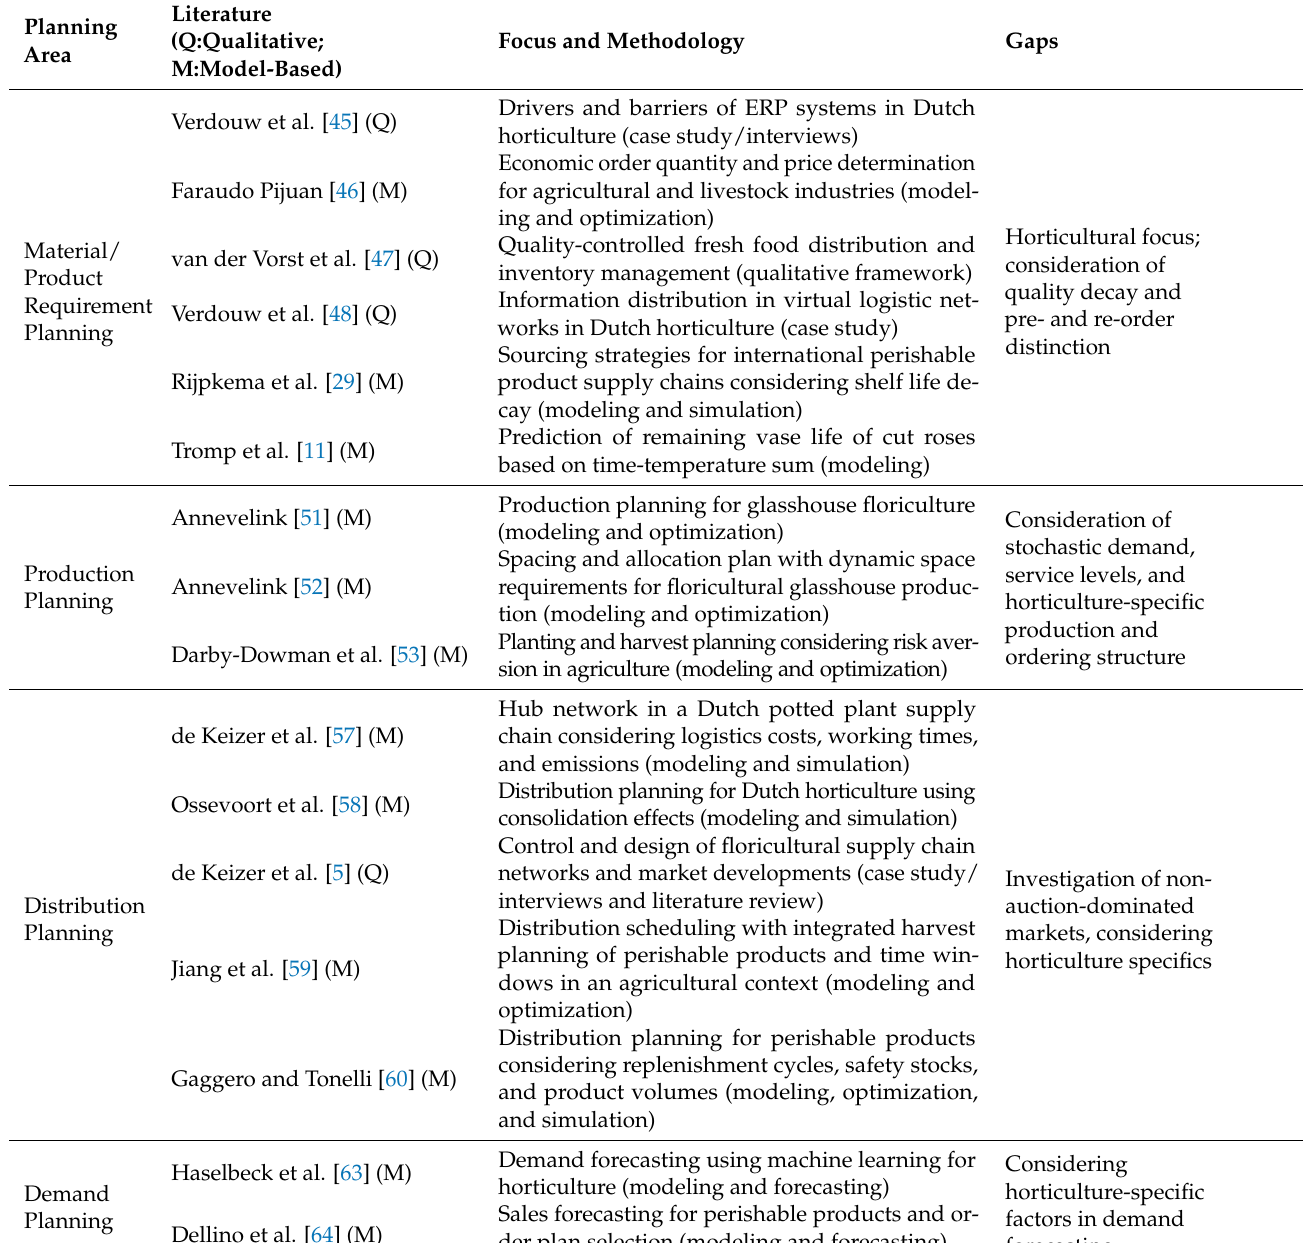
Table 3. Literature on tactical supply chain planning in horticulture or aligned